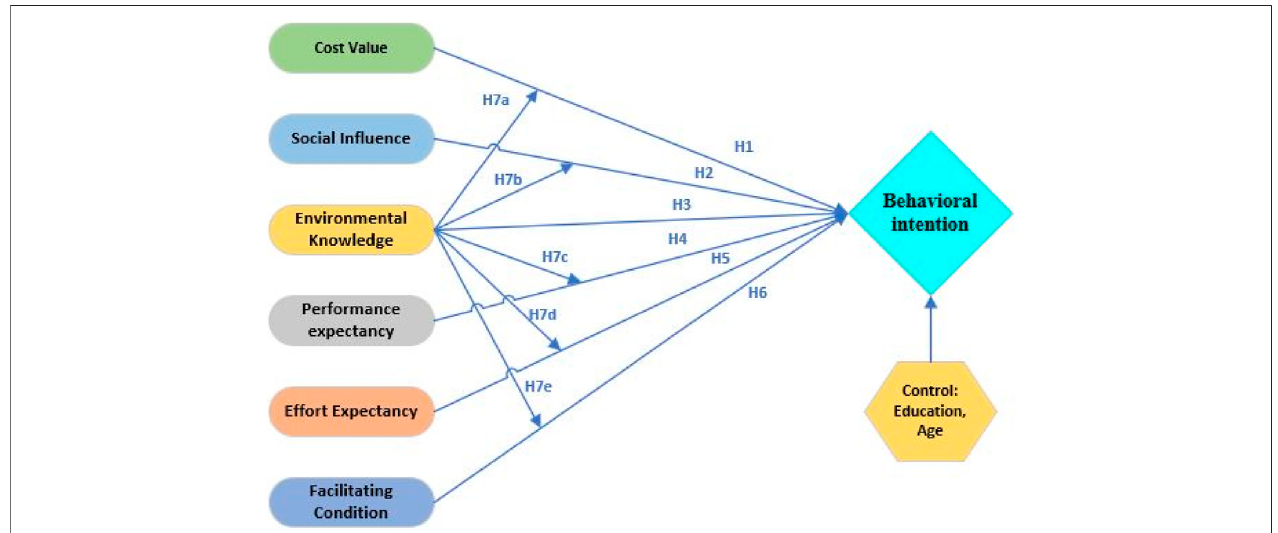
FIGURE 1 | Conceptual